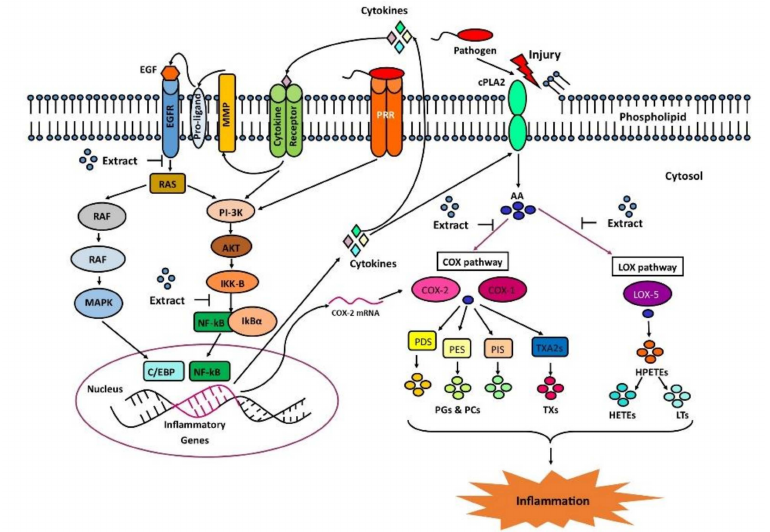
Figure 1. Inflammation can result from injury-mediated conversion of arachidonic acid (AA) metabo- lites. Synthesis of thromboxanes (TXs, red circles), prostaglandins (PGs, yellow, yellowish-green, and green circles), and leukotrienes (LTs, dark and light sky blue circles) from AA (blue circles) are regulated by largely COX-1 (magenta), COX-2 (pink) and LOX-5 (purple). In multiple cancers, EGFR plays a vital role for COX-2 induced inflammation. Pathogens can bind to PRR and initiate the PI-3k mediated signaling. PRR = pathogen recognition receptor; MMP = Matrix Metalloproteinase; EGF(R) = epidermal growth factor (receptor); RAS = rat sarcoma; RAF = rapidly accelerated fibrosar- coma; MAPK = mitogen-activated protein kinase; PI-3K = phosphoinositide 3-kinase; AKT = protein kinase B; C/EBP = CCAAT-enhancer-binding proteins; IKK-B = Inhibitor of nuclear factor kappa-B kinase subunit beta (IKK); NF-kB = nuclear factor kappa-light-chain-enhancer of activated B cells; IkB α = inhibitor of NF-kB alpha; cPLA2 = cytosolic phospholipase A2; P(D,E,I)S = prostaglandin (D,E,I) synthase; TXA2S = thromboxane-A2 synthase; TXs = thromboxanes; HPETEs = hydroperoxye- icosatetraenoic acids; HETEs = hydroxyeicosatetraenoic acids; LT =